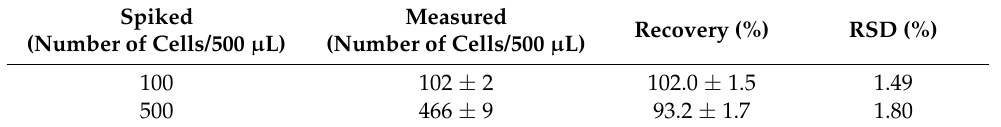
Table 2. Recoveries and RSDs of LoVo cells at two concentrations (n =